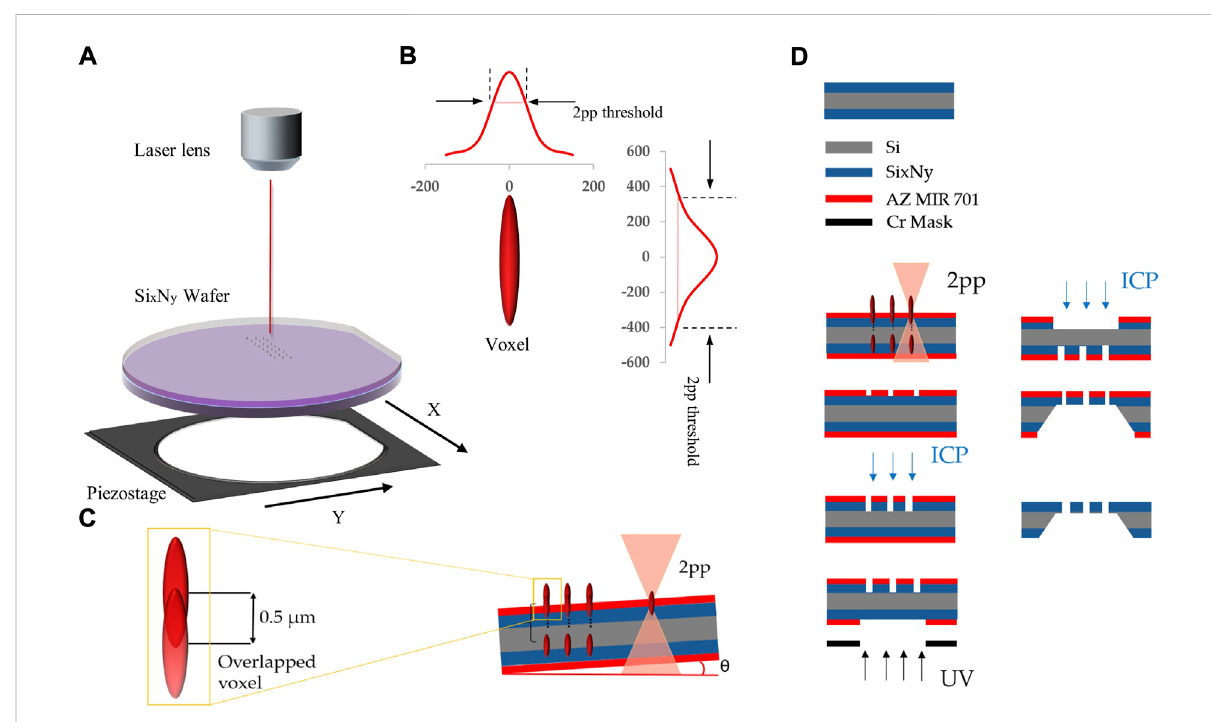
FIGURE 2 (A) Schematic of the 2pp exposure setup using a focused femtosecond-laser-beam and a piezostage with a position accuracy < 10 nm. (B) Laser intensity pro fi le following a Gaussian distribution and creating an ellipsoidal volume element of polymerized photoresist (voxel) (Fischer and Wegener, 2013). (C) Positioning ofmultipleoverlappingvoxelsforcreating anexposure foroneporeinthephotoresist (red)ontopoftheSi x N y layer. This approach is robust against hard to avoid substrate tilt θ . (D) Schematic illustrating the complete wafer level membrane fabrication process